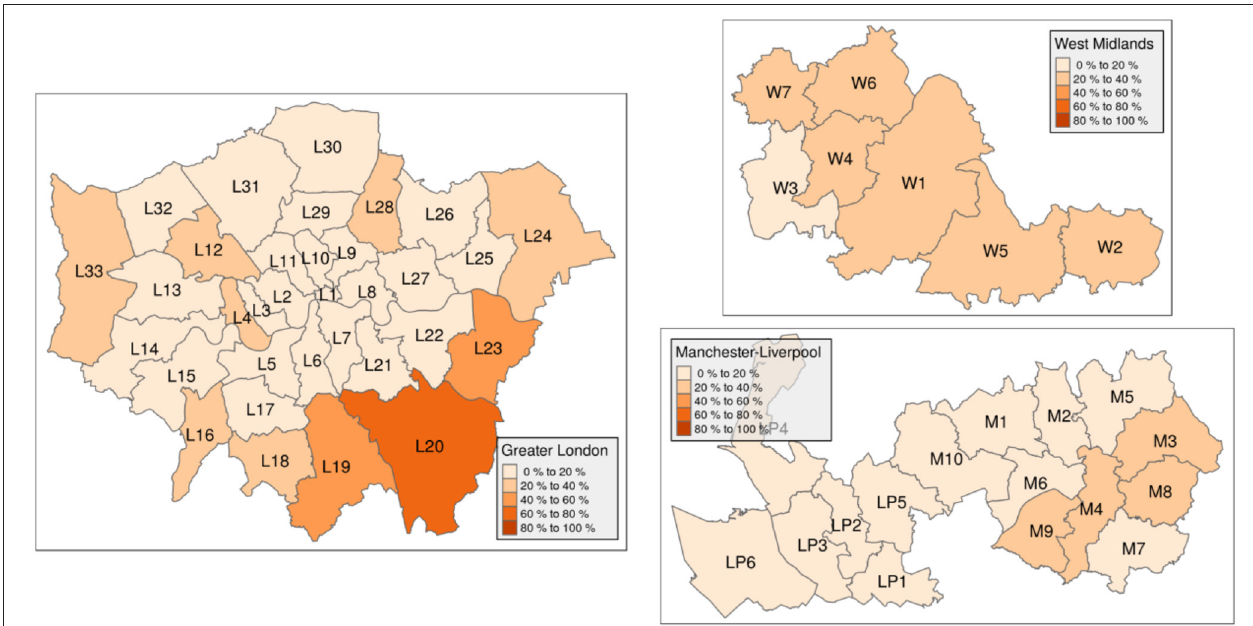
FIGURE 4 | Percentage of academies in 2017 in London, West Midlands and Manchester-Liverpool conurbations (see codes for local authorities in Table A1 ).